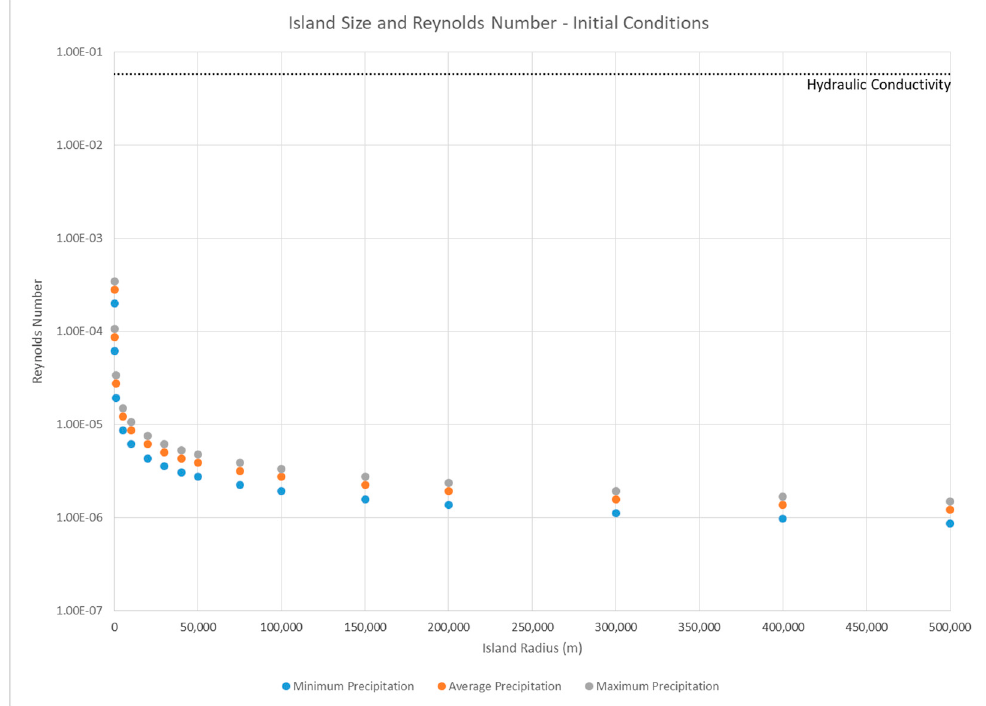
Figure 11. The initial condition (radius = 0.0005 m) trial Reynolds numbers under the three different recharge rates. Note that the Reynolds numbers for all of the different island sizes are below the hydraulic conductivity suggested by Whitaker and Smart [28], 5 m day − 1 . This suggests that the islands regardless of size can all discharge the aquifer through diffuse flow as n-D tubes. However, karst aquifers are heterogeneous, non-isotropic, and self-modifying, and as such, they will self-organize, developing touching-vug porosity and cavernous porosity (e.g., conduits) given sufficient time and